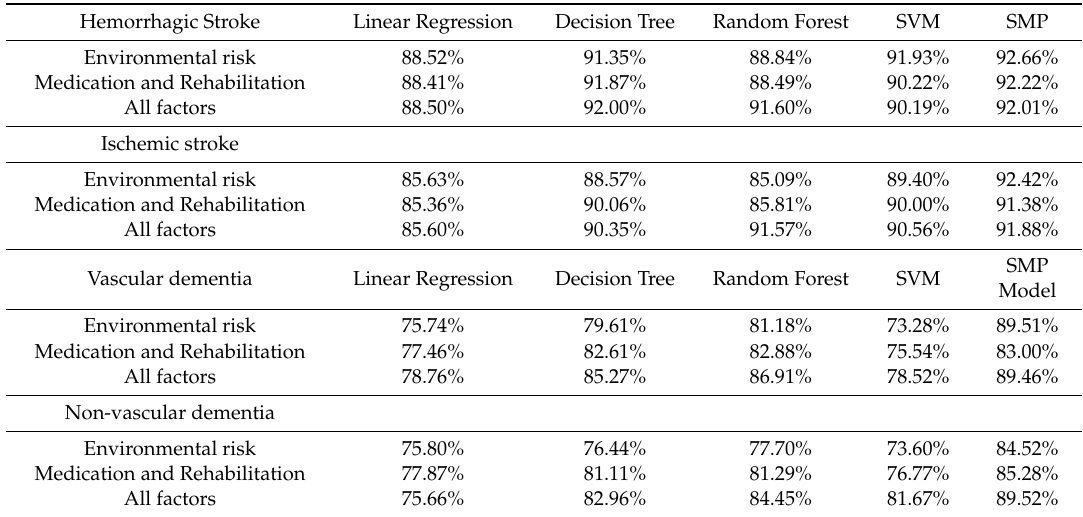
Table 7. R 2 of SMP comparison with benchmark